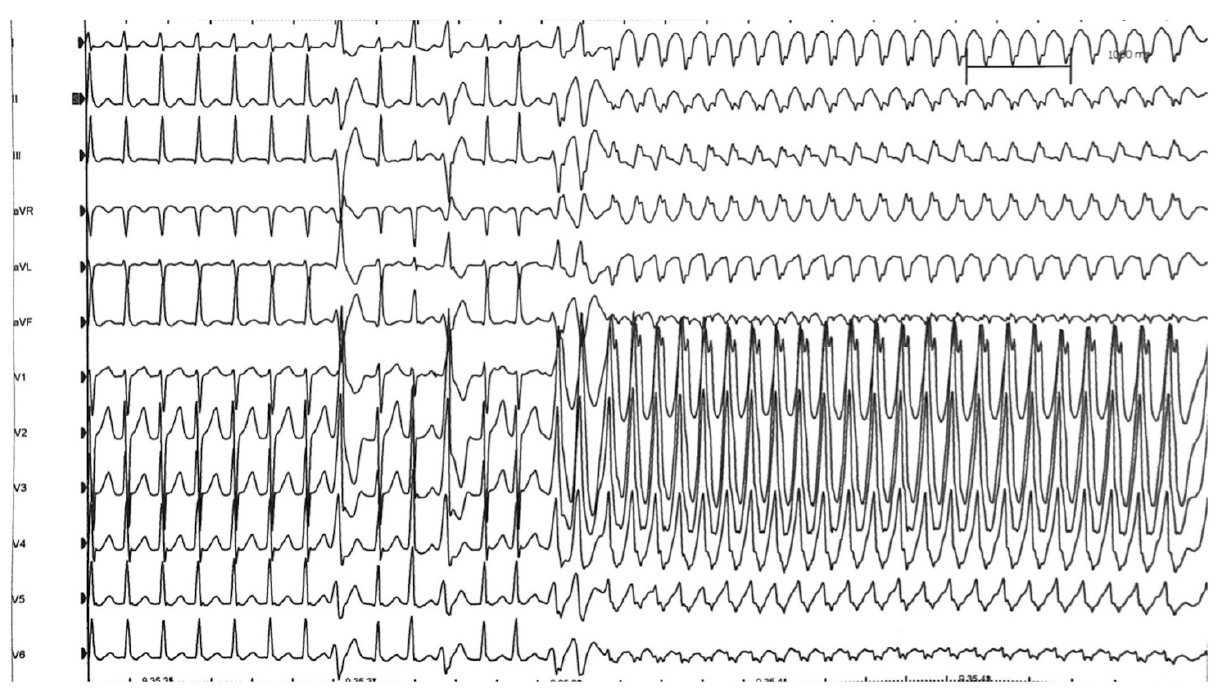
Figure 4. Electrophysiological Study: orthodromic atrioventricular reentrant tachycardia degenerating into atrial fibrillation with a very high ventricular rate response along a left accessory pathway.